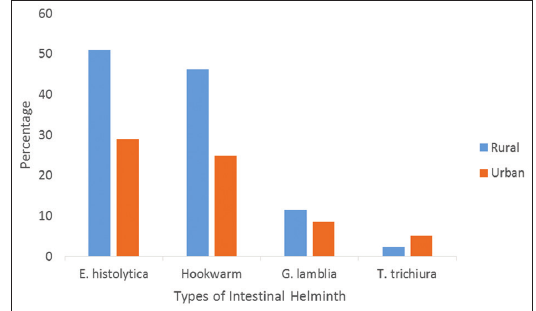
Figure 1 : Prevalence of intestinal parasites among children in rural and urban